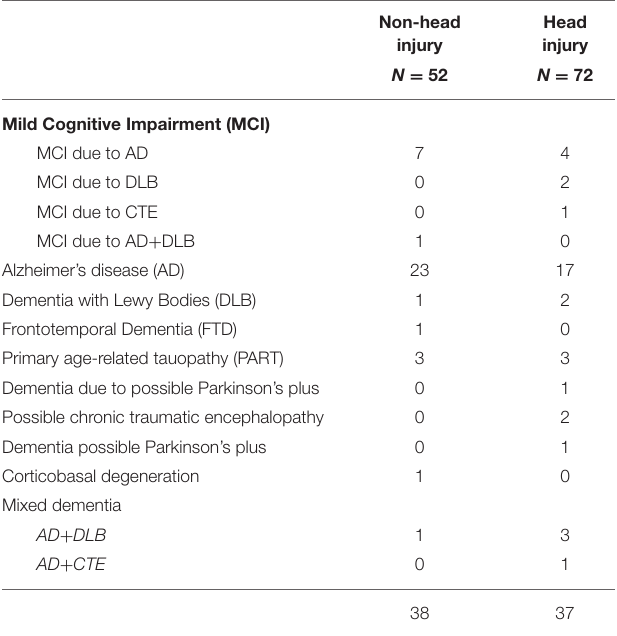
TABLE 4 | Neurodegenerative clinical diagnoses.